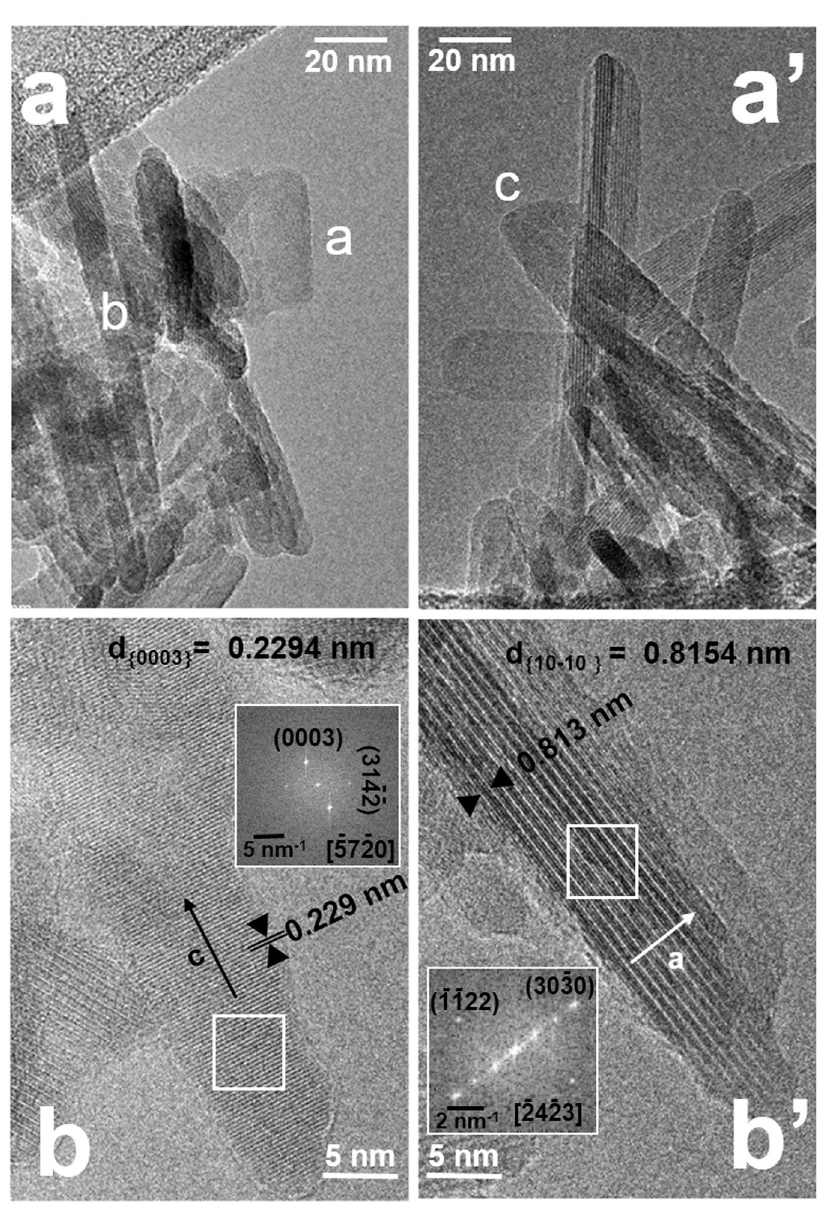
Figure 1. Representative TEM images of Cit-HA-24h. Original magnification: ( a,a ’) 150 k × ; ( b,b ’) 400 k × . Insets in b , b ’: FT of the image portions enframed within the white